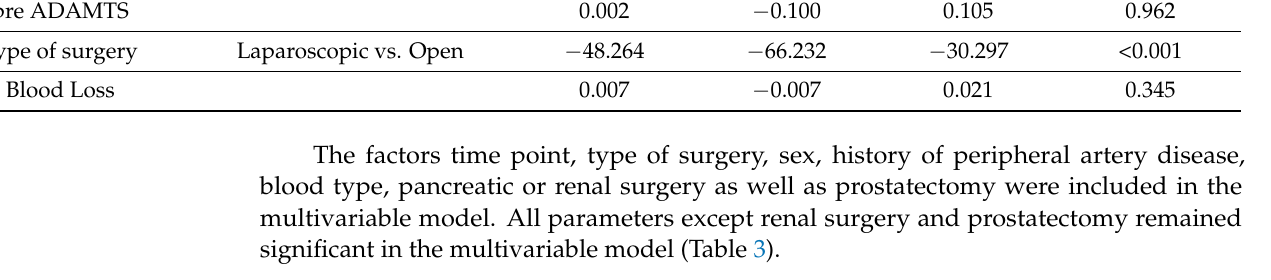
Table 3. Multivariable regression model vWF. The estimated effect sizes, confidence levels and p-values were calculated using multivariable regression models (with random factor patient). pre, preoperative; 2 h post, within two hours after surgery; POD, postoperative day; CL, confidence